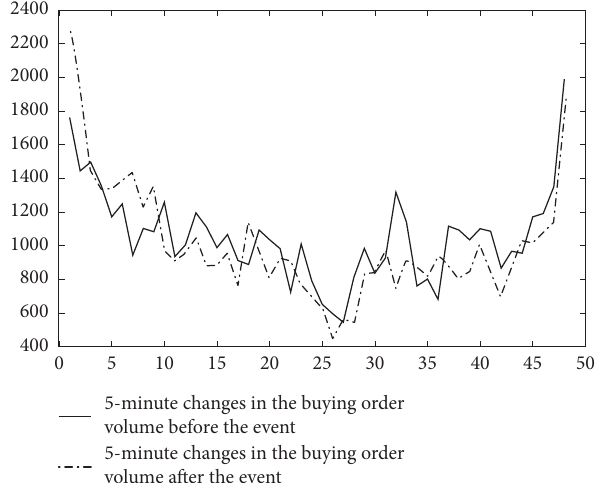
Figure 4: The intraday changes in the buying order volume for the IC dominant contract (five minutes).